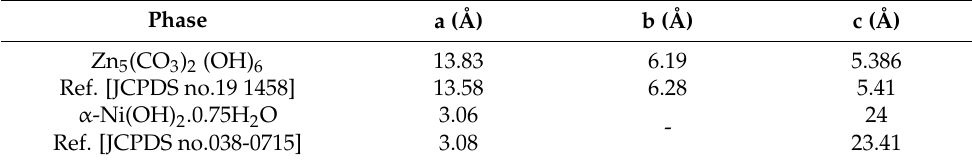
Table 1. Structural characteristics of Ni/Zn based bi-phase nanohybrid.